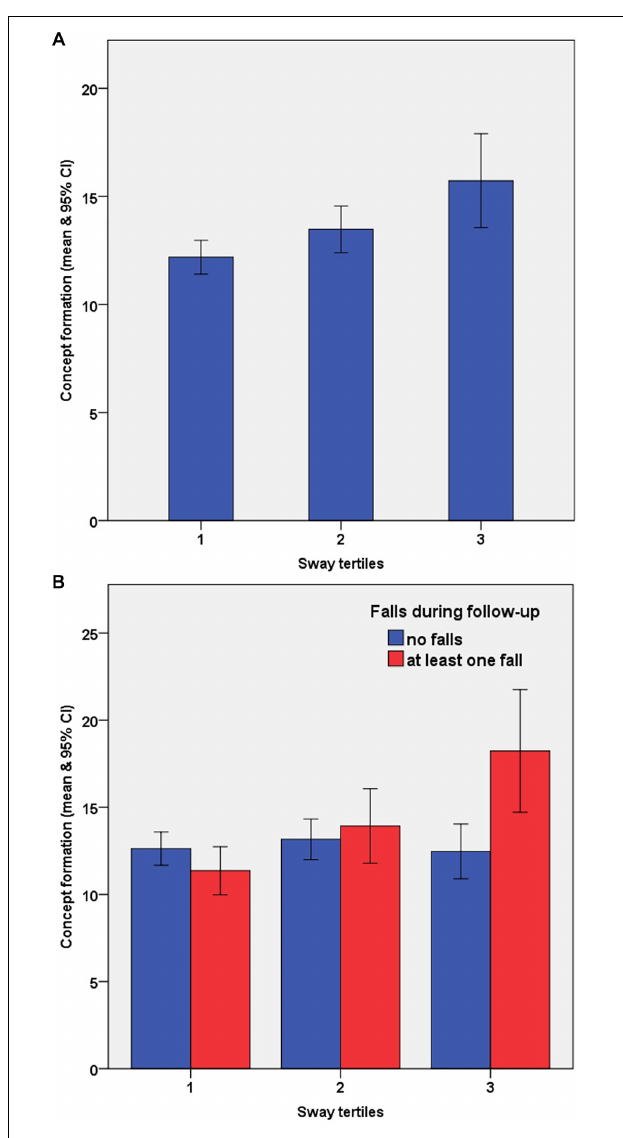
FIGURE 1 | Concept formation ability as measured by the number of trials needed to shift first set during the short version of the Wisconsin Card Sorting Test (WCST) according to balance (sway tertiles) and faller status (one or more falls). Panel (A) shows a decline in concept formation performance across sway tertiles; Panel (B) shows the additional impact of faller status. Across sway tertiles the concept formation ability did not differ in non-fallers (blue). However, with decreasing balance status, fallers had greater difficulties to implicitly understand the first rule